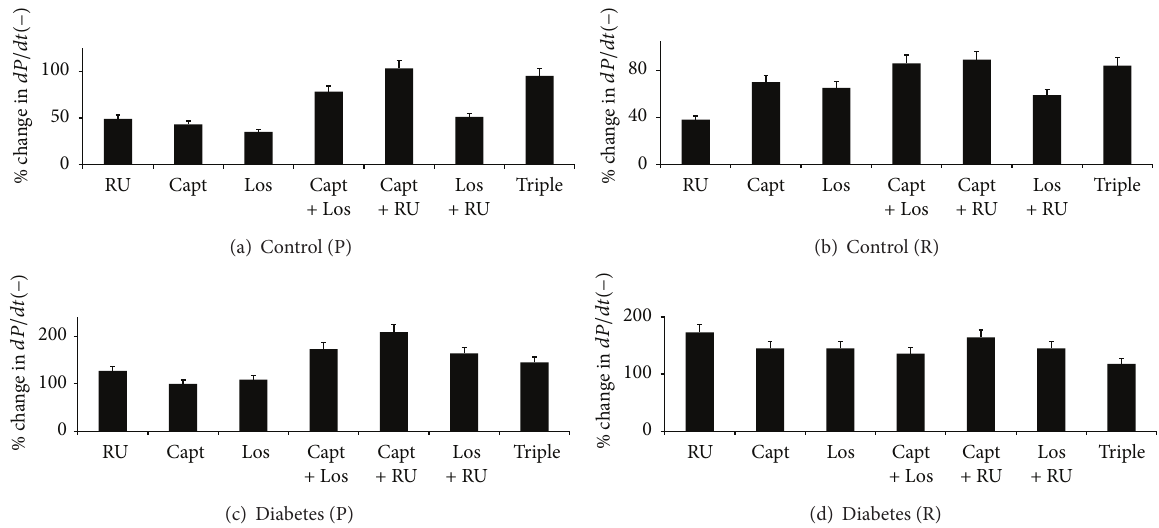
Figure 8: A comparison of the % change in negative derivative of pressure ( −𝑑𝑃/𝑑𝑡 ) in control and diabetic hearts following acute treatment with various drug regimens. Drugs were given to control hearts during perfusion (a) or reperfusion (b) and to diabetic hearts during perfusion (c) or reperfusion (d). The percent change in parameter is calculated relative to the % recovery seen in the respective nondiabetic or diabetic controls. RUL: RU28318; Capt: Captopril; Los: Losartan; Triple: RU28318 + Captopril +